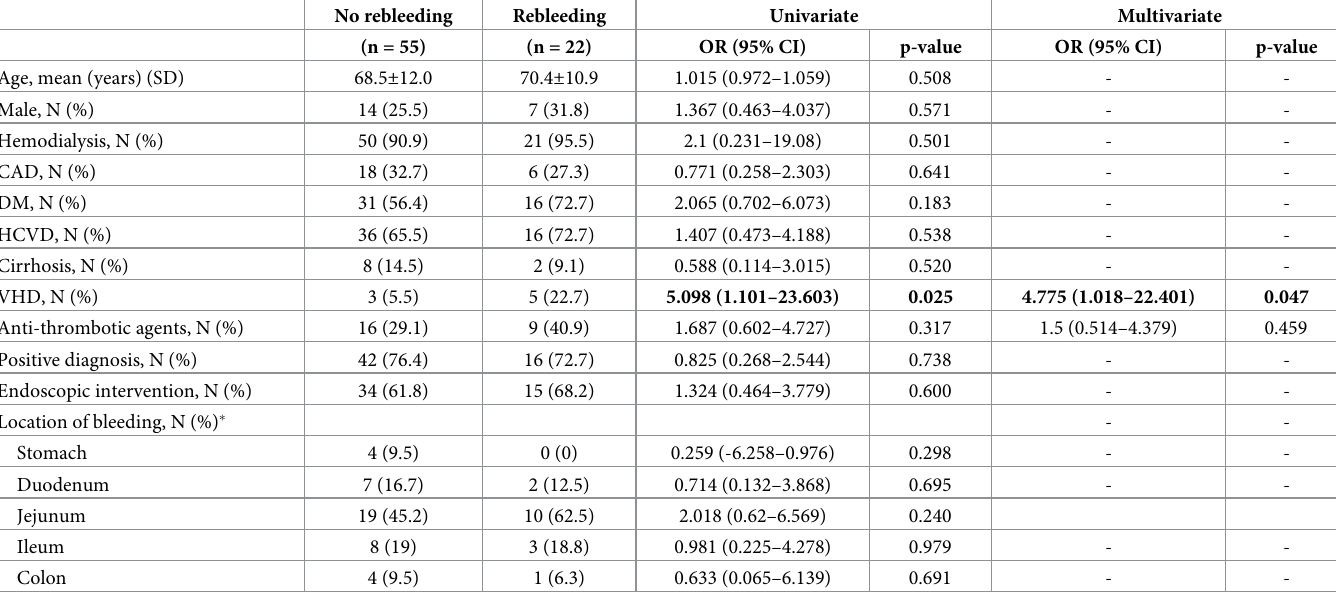
Table 4. Risk factors for rebleeding in uremic patients with obscure gastrointestinal bleeding. No rebleeding